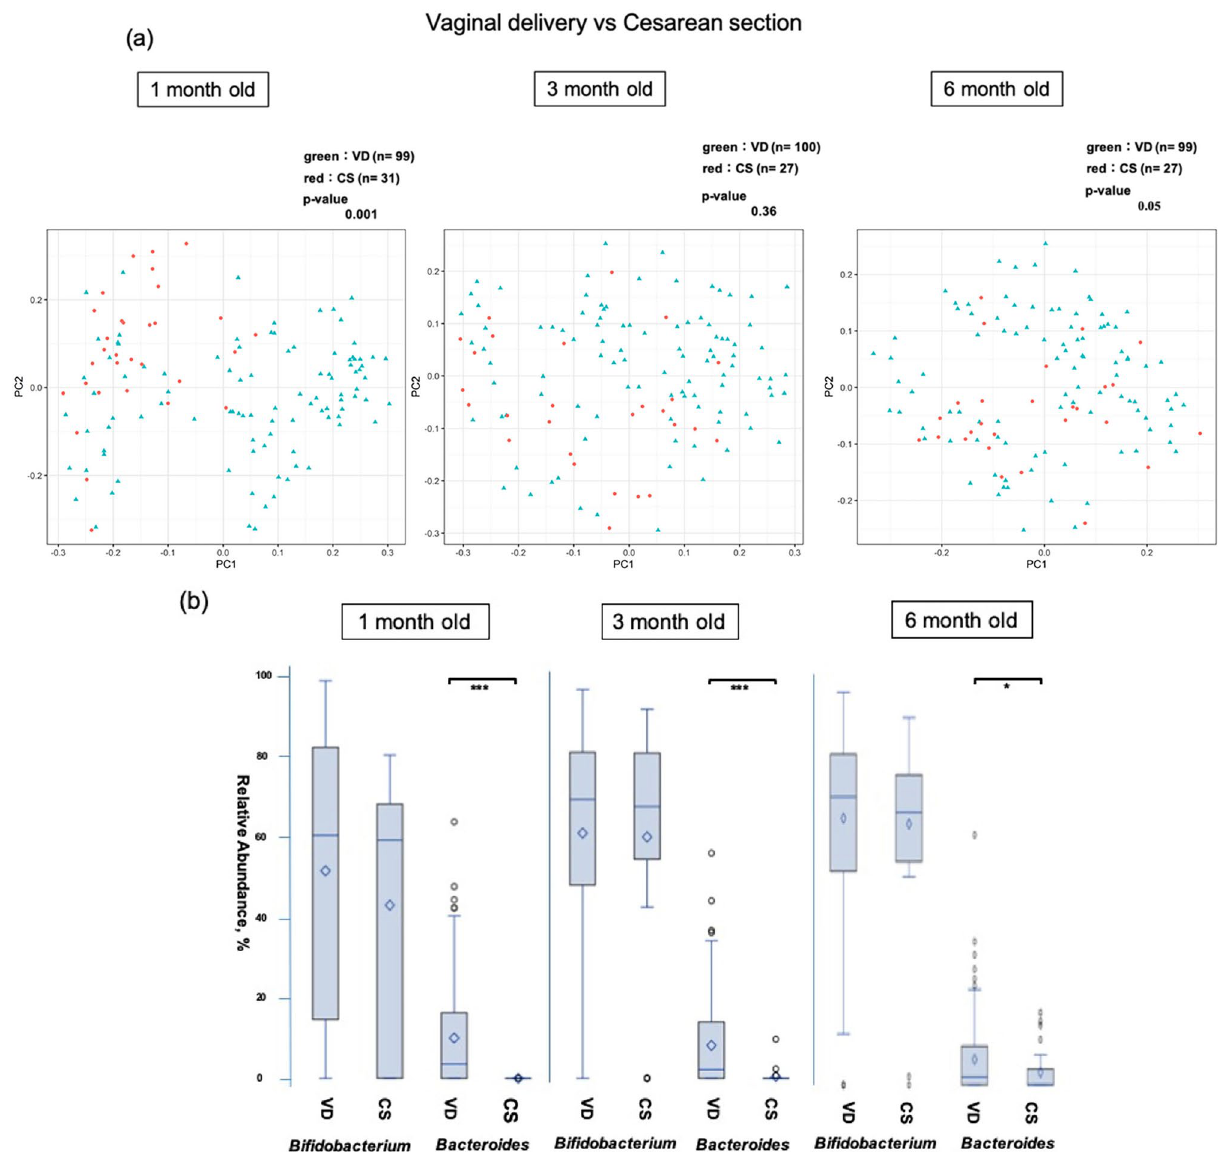
Figure 4. Comparison of the β diversity and occupancy of the top two bacteria species in the vaginal delivery (VD) and caesarean section (CS) groups. ( a ) Comparison of β diversity of the intestinal microbiome at each age between vaginal delivery (VD) and caesarean section (CS) ( b ) Bifidobacteria and Bacteroides occupancies between delivery methods, shown as box-whisker plots at each age. The VD and CS groups included 99 and 31 infants at 1 month (130 in total), 100 and 27 infants at 3 months (127 in total), and 99 and 27 infants at 6 months (126 in total). The significance level was set at 5%. * p < 0.05, *** p < 0.001 using Mann–Whitney U-test. This figure was generated using SAS version 9.4 (https